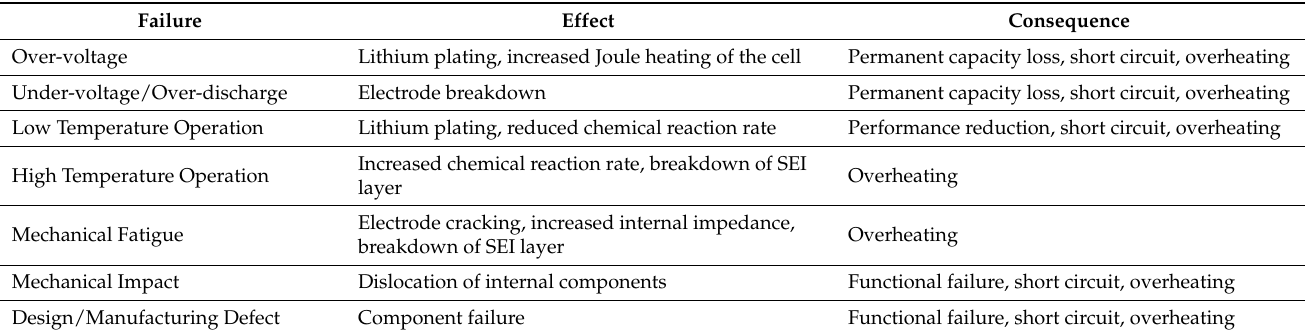
Table 3. Lithium-ion Battery Failures Leading to Fire.